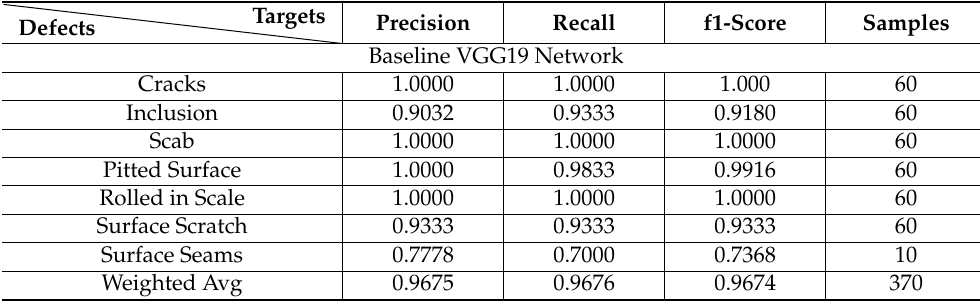
Table 2. Report on the test